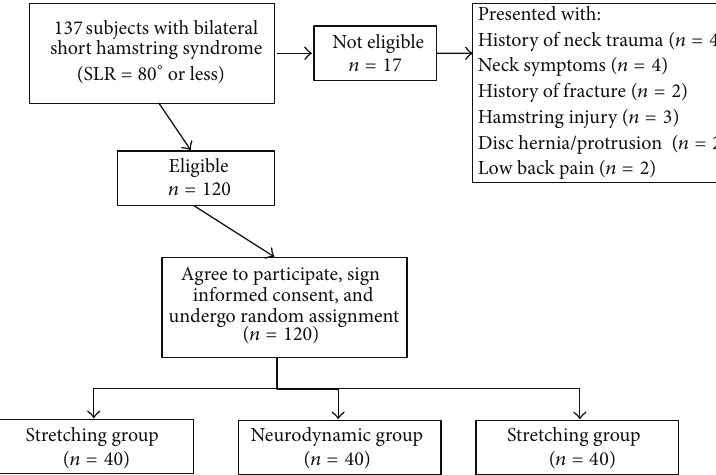
Figure 1: CONSORT flow diagram of patient recruitment and retention.